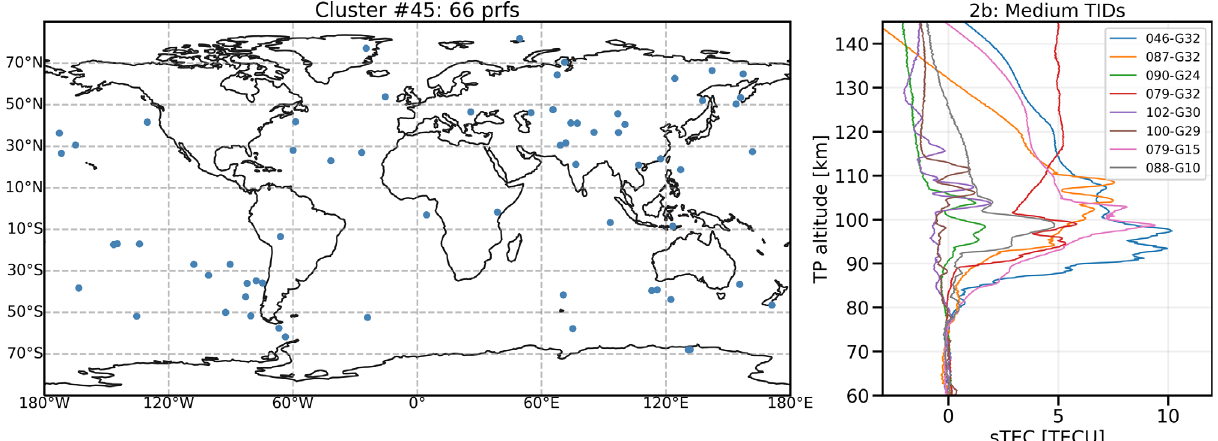
Fig. 10. Ionospheric perturbations example cluster. The left map shows the location of the 66 sTEC pro fi les within the cluster. On the right, 8 randomly selected pro fi les from the cluster. All the pro fi les show similar medium-scale TIDs structures.